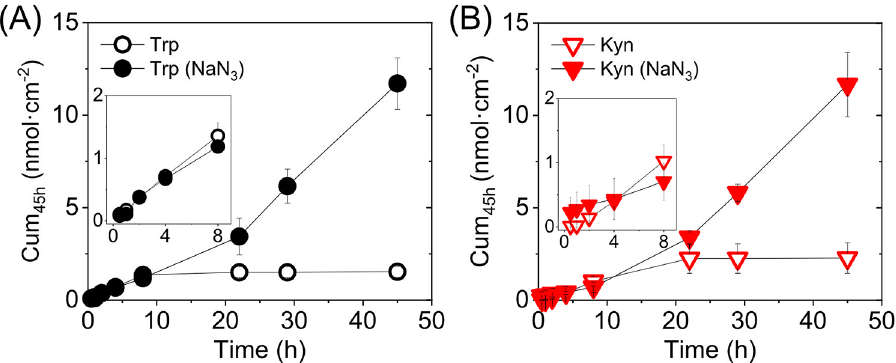
Figure 5. Cumulative permeated amount of ( A ) Trp and ( B ) Kyn through skin with ( n = 6) and without ( n = 3) presence of the antimicrobial agent sodium azide (15 mM NaN 3